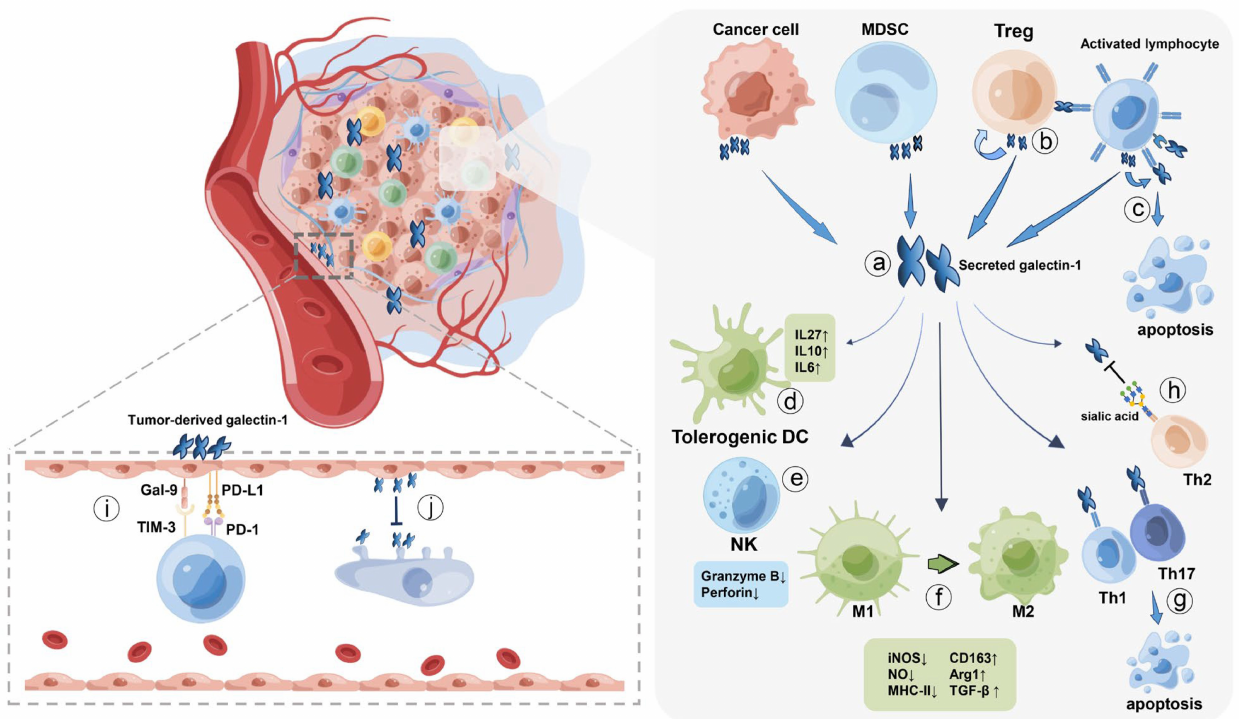
Figure 1. The roles of galectin-1 in the tumor microenvironment. (a) Galectin-1 was reported to be secreted by cancer cells, myeloid-derived suppressor cells (MDSC), regulatory T cells (Treg), and activated T lymphocytes in the tumor microenvironment. (b) Galectin-1 is able to promote the expansion of Treg cells and act as a mediator maintaining the immunosuppressive property of Treg cells. (c) In addition to inducing apoptosis of activated T lymphocytes, galectin-1 also acts as a negative autocrine regulator. (d) Galectin-1 in the tumor microenvironment is capable of enhancing the tolerogenic ability of mature dendritic cells (DC) and promoting the secretion of immunosuppressive cytokines such as IL-27, IL-10 as well as IL-6. (e) Secreted galectin-1 impairs the tumor-killing effects of natural killer (NK) cells by attenuating the release of Granzyme B and Perforin. (f) Galectin-1 may give rise to macrophage polarization from M1 to M2 type with decreased biomarkers of M1 (iNOS, NO, and MHC-II) and elevated biomarkers of M2 (CD163, Arg1, and TGF- β ). (g) Th1 and Th17 cells share a common glycan motif and are both susceptible to apoptosis induced by galectin-1. (h) Galactose- β 1-4-N-acetylglucosamine ligands on the surface of Th2 cells, which were proved to be binding sites of galectin-1, were covered by sialic acid produced by α 2-6 sialyltransferase (ST6Gal1), thus contributing to apoptosis resistance induced by galectin-1 binding. (i) Low concentrations of galectin-1 in the early stage of cancer can reprogram the tumor endothelium to elevate the expression of galectin-9 and PD-L1, thus mediating T-cell exclusion. (j) Endothelium- derived galectin-1 was found to act as a negative regulator limiting T cell rolling, capture as well as adhesion to endothelial